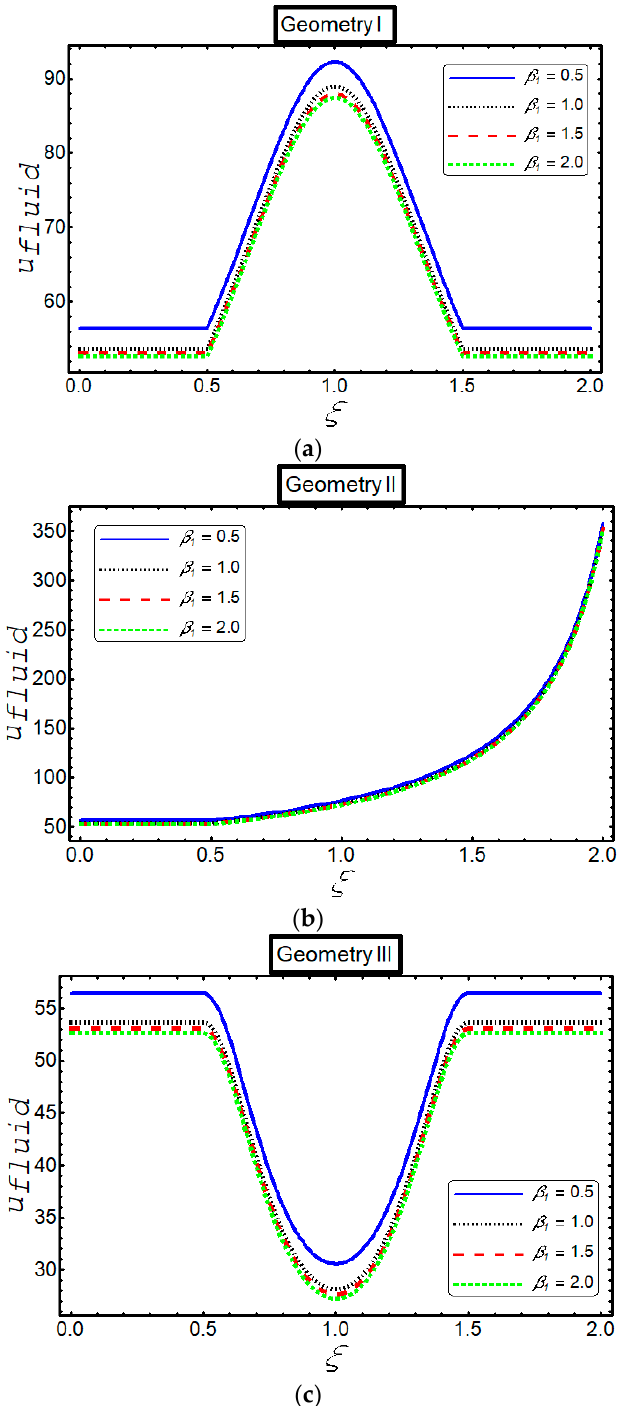
Figure 10. Velocity variation for slip parameter 𝛽 (cid:2869) .